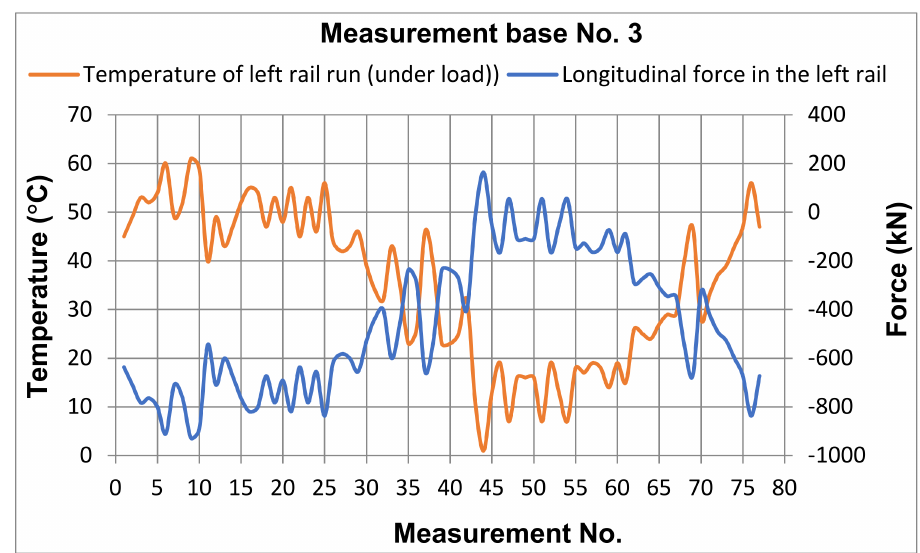
Figure 10. Results of measurements of temperature and longitudinal force of left rail after loading by a passing train—measurement base No. 3 (source: own work).